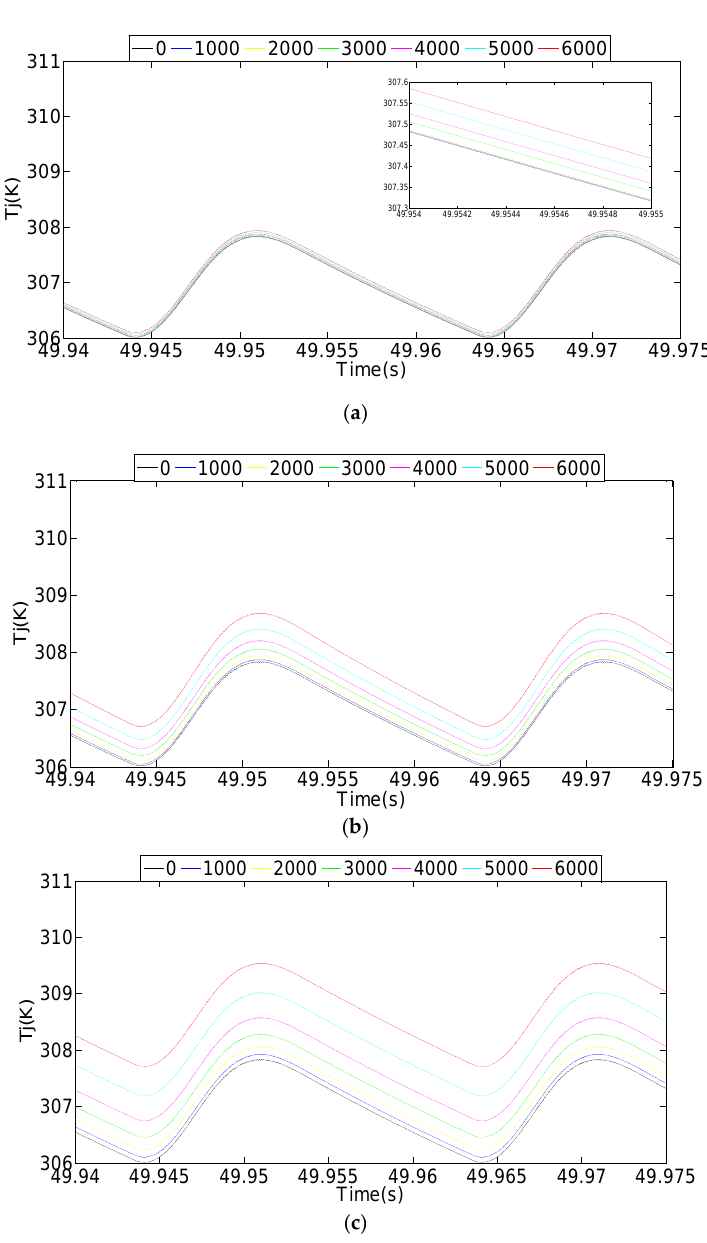
Figure 9. The steady state junction temperature with the change of electro-thermal parameters. ( a ) The steady state junction temperature with the change of V ceo and r ce ; ( b ) The steady state junction temperature with the change of E on and E off ; ( c ) The steady state junction temperature with the change of Z th,jc .